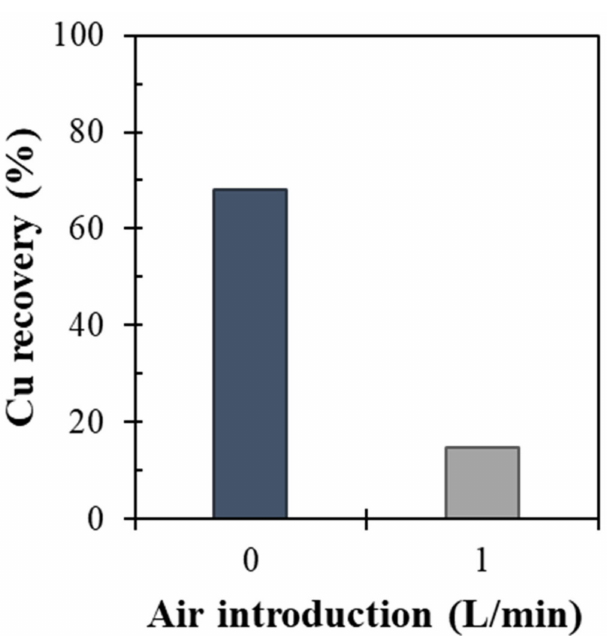
Figure 3. Effect of air introduction during ME treatment with 10 mM Fe 2 + /H 2 PO − of